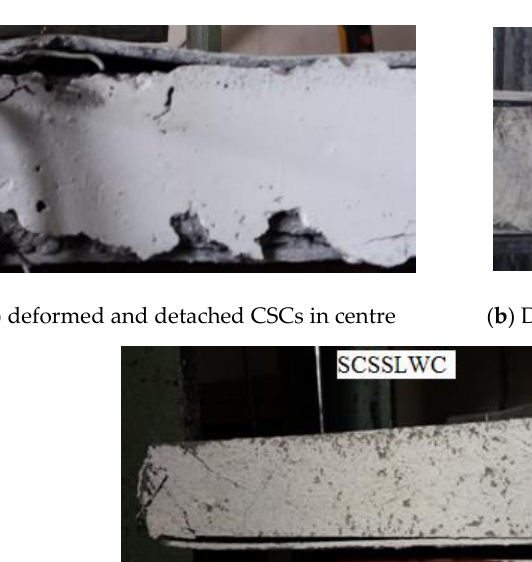
Figure 13. Punching shear failure mode in the specimens.